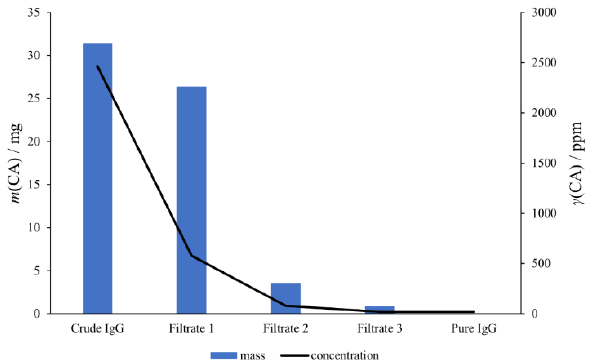
Figure 4. CA removal monitoring during diafiltration step of the refinement protocol for IgG purification, performed by quantification of CA amount in crude IgG, filtrates after each diafiltration step, and final pure IgG.